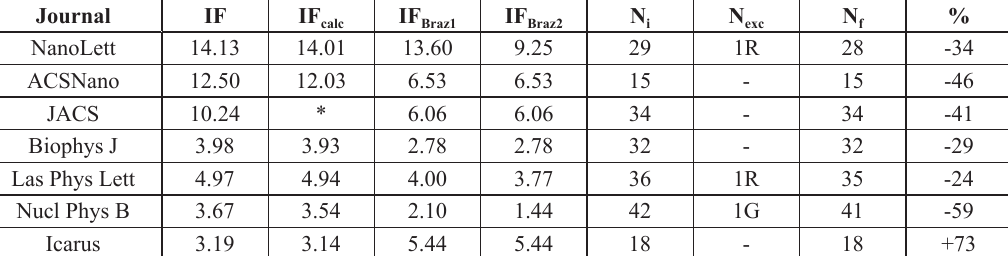
is the total number of i